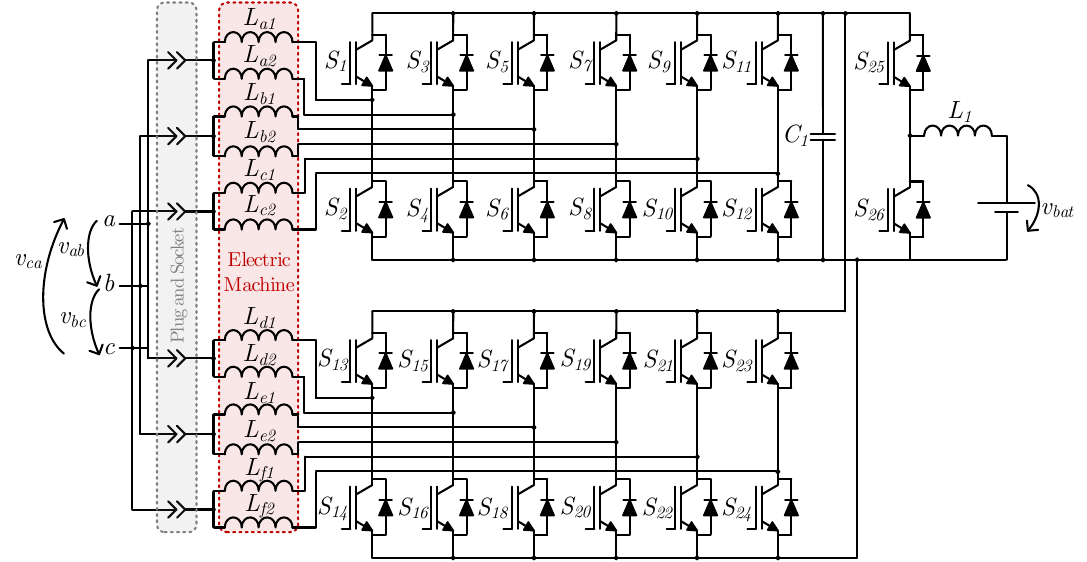
Figure 21. EV IBC proposed by H. Raherimihaja et al. in 2020 [46].